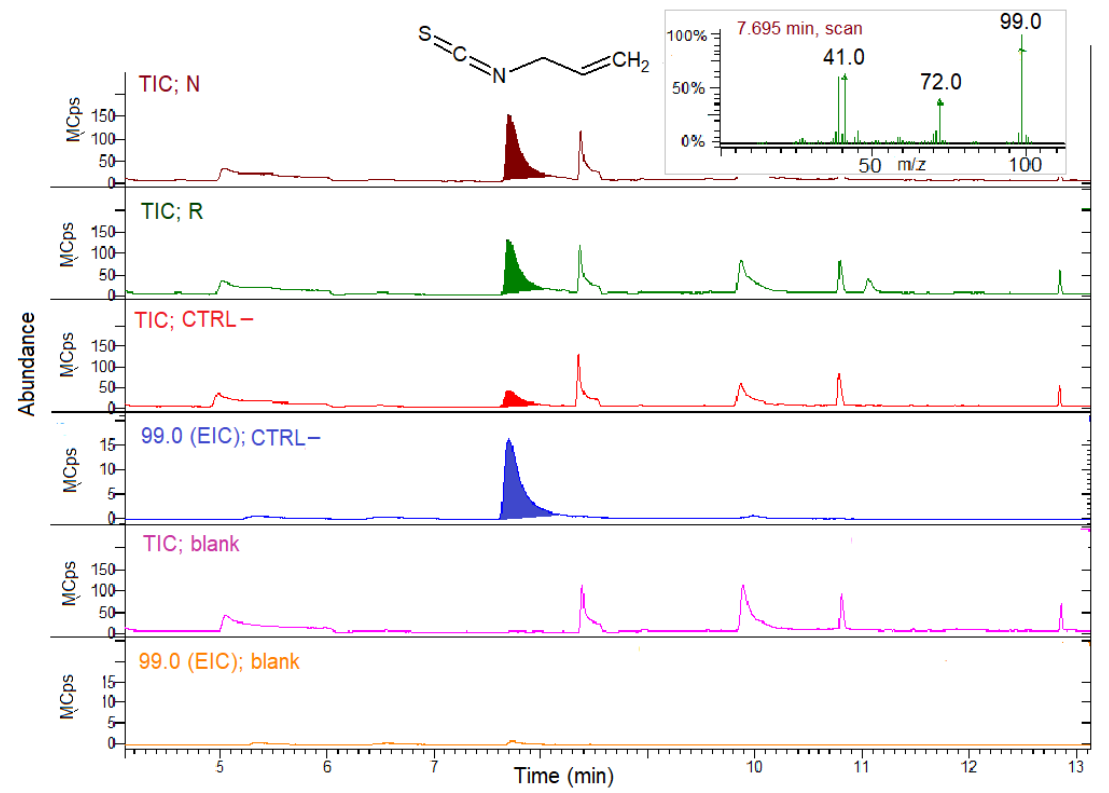
Figure 4. SPME GC–MS analysis of concentrated midgut extracts from the bees fed on N, R and CTRL– patties for myrosinase activity detection with sinigrin (SIN) as the substrate. Blank sample chromatograms represent the analysis of the buffer with SIN, but without the gut extract. TIC, total ion chromatogram; EIC; extracted ion chromatogram (99.0 m/z for allyl isothiocyanate, AITC). Inset: AITC MS spectrum.